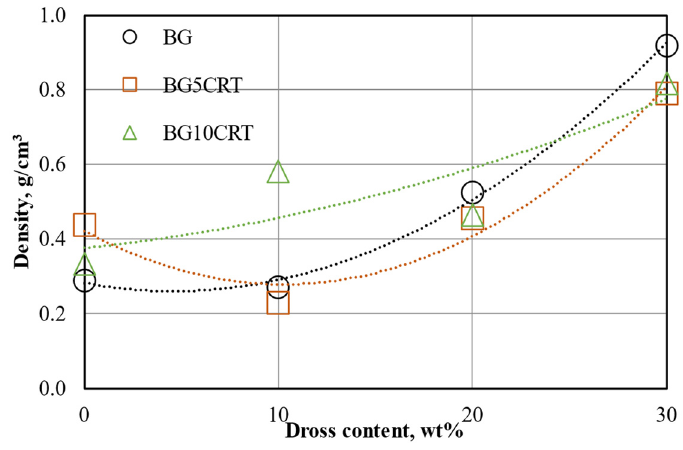
Figure 8. Bulk density of the samples of foam glasses.